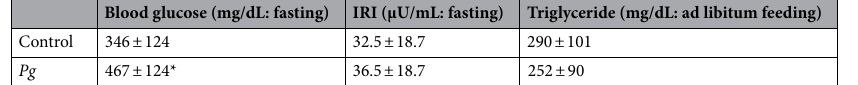
Table 2. Blood glucose and serum insulin levels at fasting condition, and serum triglyceride levels at ad libitum feeding condition in Porphyromonas gingivalis ( Pg )- and CMC-treated db / db mice. Glucose and insulin levels were measured 3 weeks after treatment, and triglyceride levels 4 weeks after treatment. Data are expressed as mean ± standard error of mean. IRI: immunoreactive insulin. * P < 0.05 compared with the control; n =